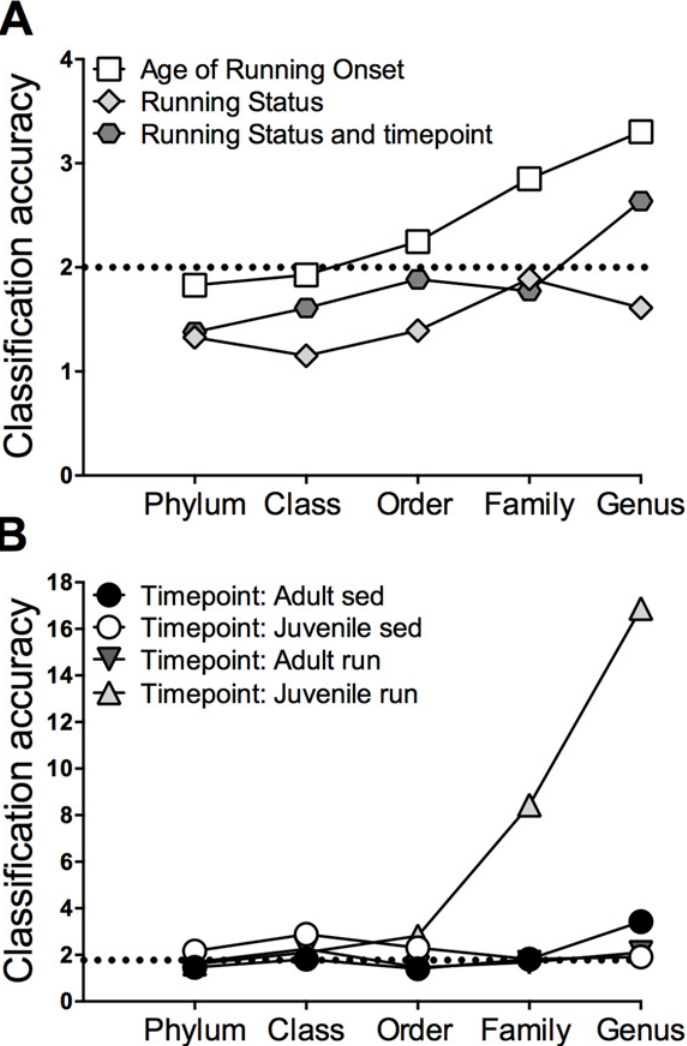
Fig 5. Supervised learning analyses: early life exercise altered specific genera. Classification accuracy generated from supervised learning depicted across each level of taxonomy. A) When samples were collapsed into age of running onset, running status, and running status and time point categories, the highest classification accuracy was observed for age of running onset. B) Next, the algorithm attempted to classify time of sample collection separately for each experimental group. The classification accuracy of predicting time point increased to 16.875 times better than random guessing for juvenile runners only, indicating that certain genera were significantly altered across time in juvenile